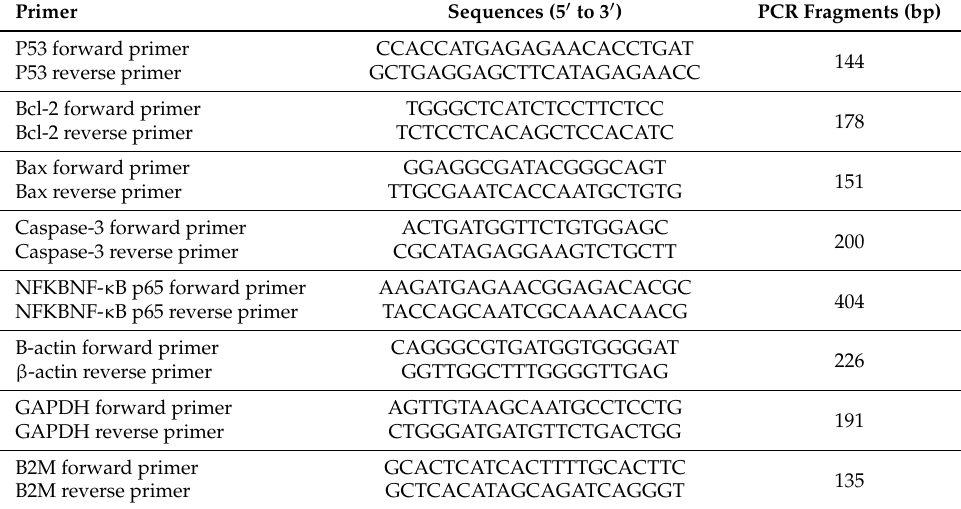
Table 1. Primer sequences for